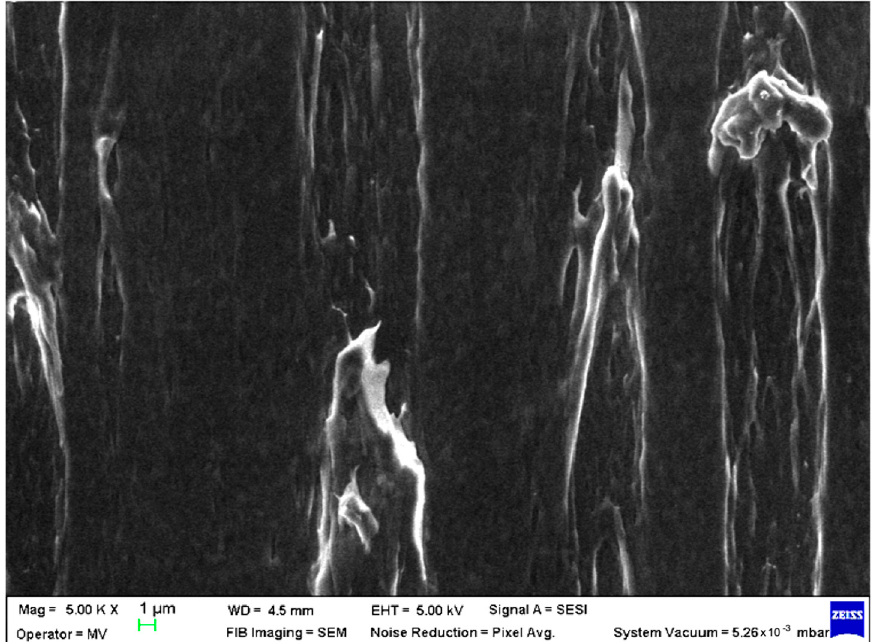
Figure 11. SEM micrographs of PET–HDPE composite (M11) sample at T 0 (1 μ m scale).